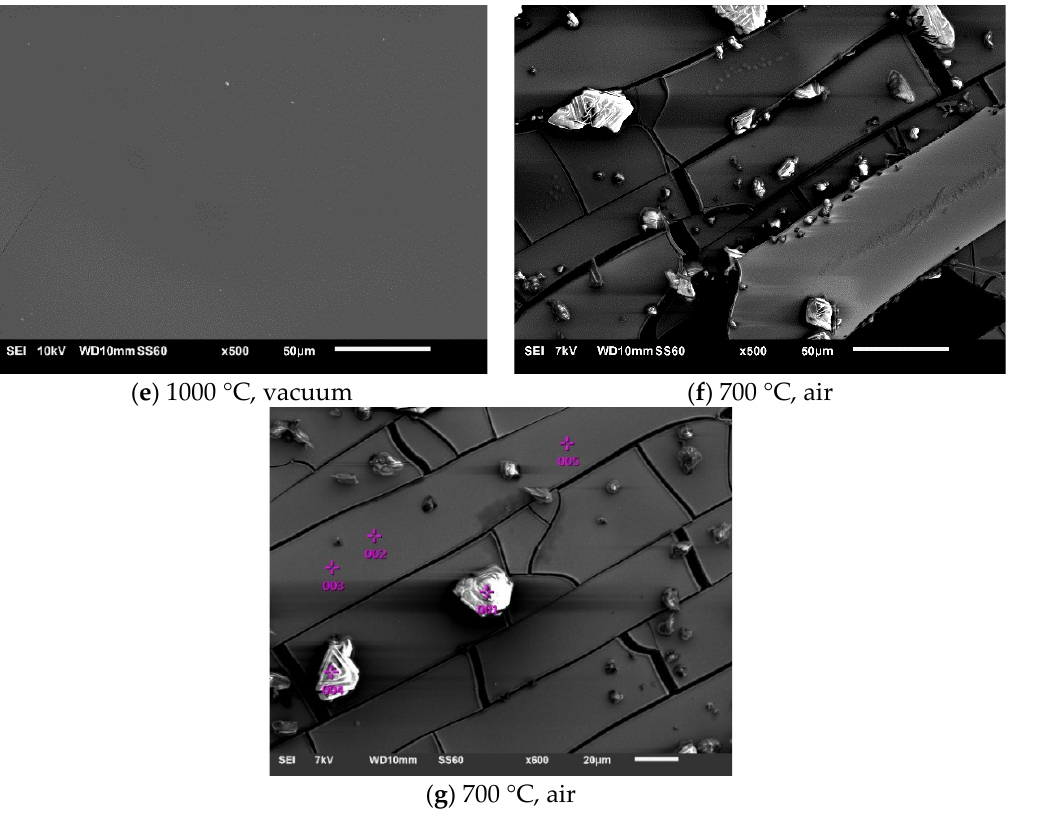
Figure 6. SEM images of coatings treated in vacuum at (a) 700 °C and (c,e) 1000 °C, and in air at (b) 500 °C and (d,f,g) 700 °C.